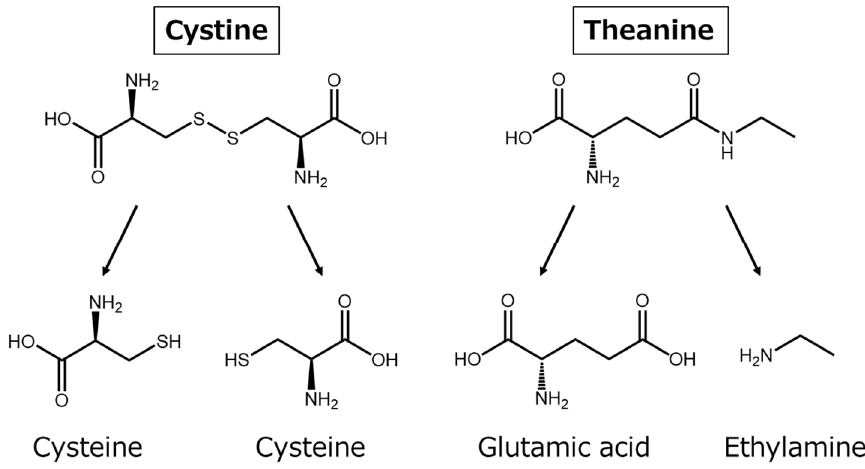
Figure 2. Chemical structure of cystine and theanine and metabolism in the body.